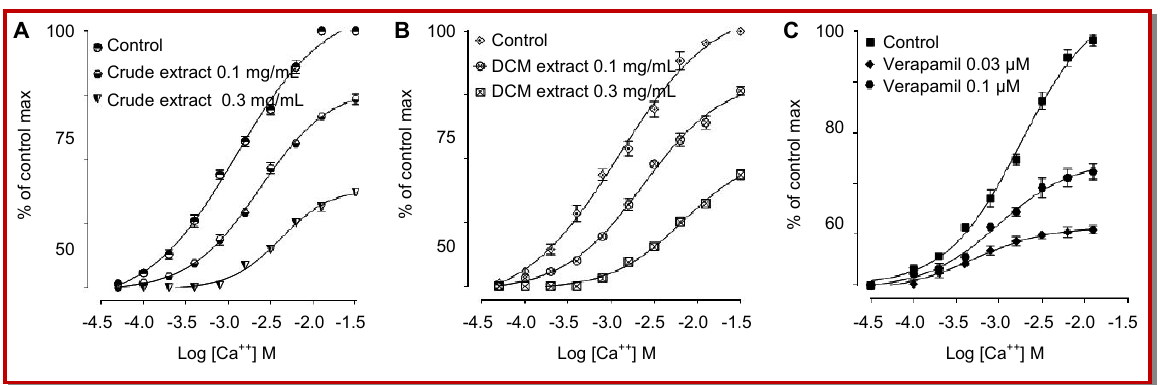
Figure 1: Dose-dependent inhibitory effect of crude extract (A), DCM extract (B) and aqueous extract (C) against spontaneous contractions and K + (80 mM)-induced contractions in comparison to verapamil (D) in isolated rabbit jejunum preparations. Values shown are mean ± SEM (n=5-6)